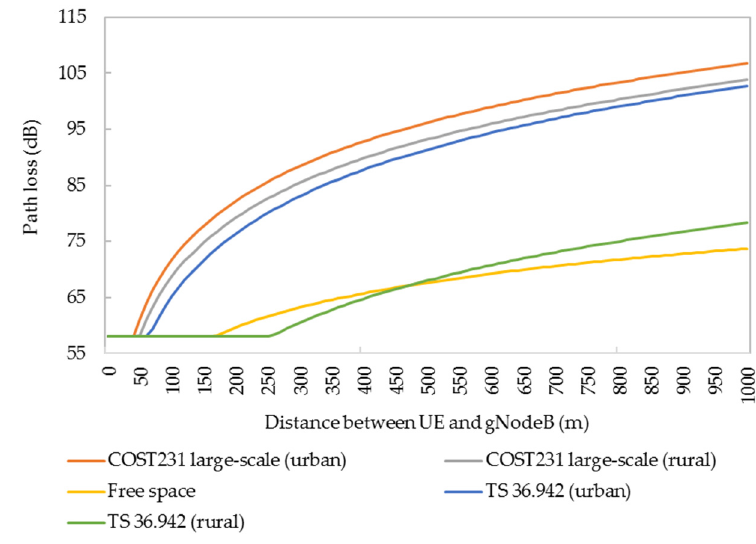
Figure 14. Path losses under different scenarios and different models.